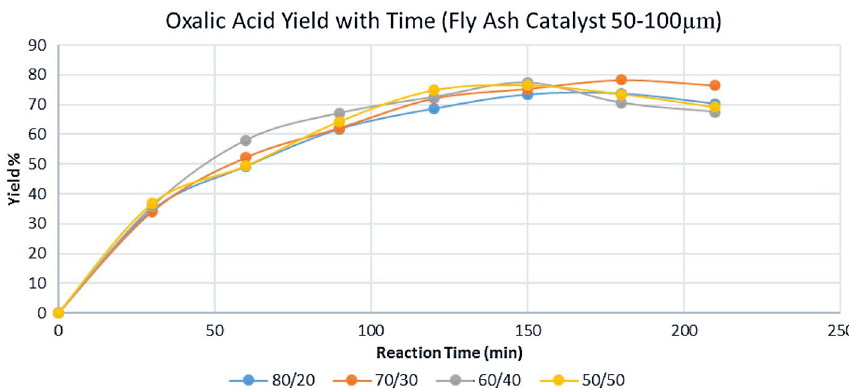
Fig. 5 Yield of oxalic acid using fine fly ash